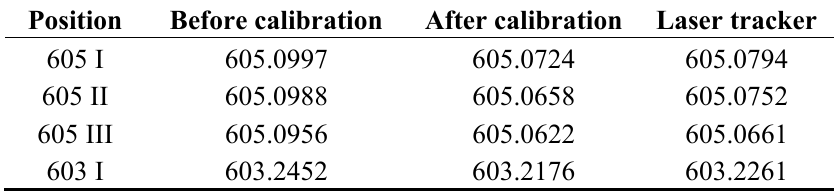
Table 3. Diameters measured in the field before and after calibration (mm).